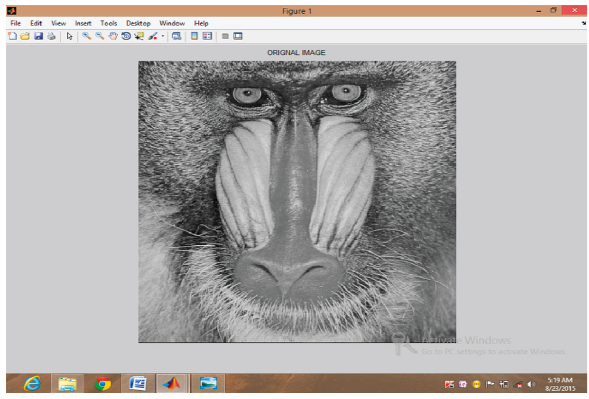
Figure 11: Original image of baboon.